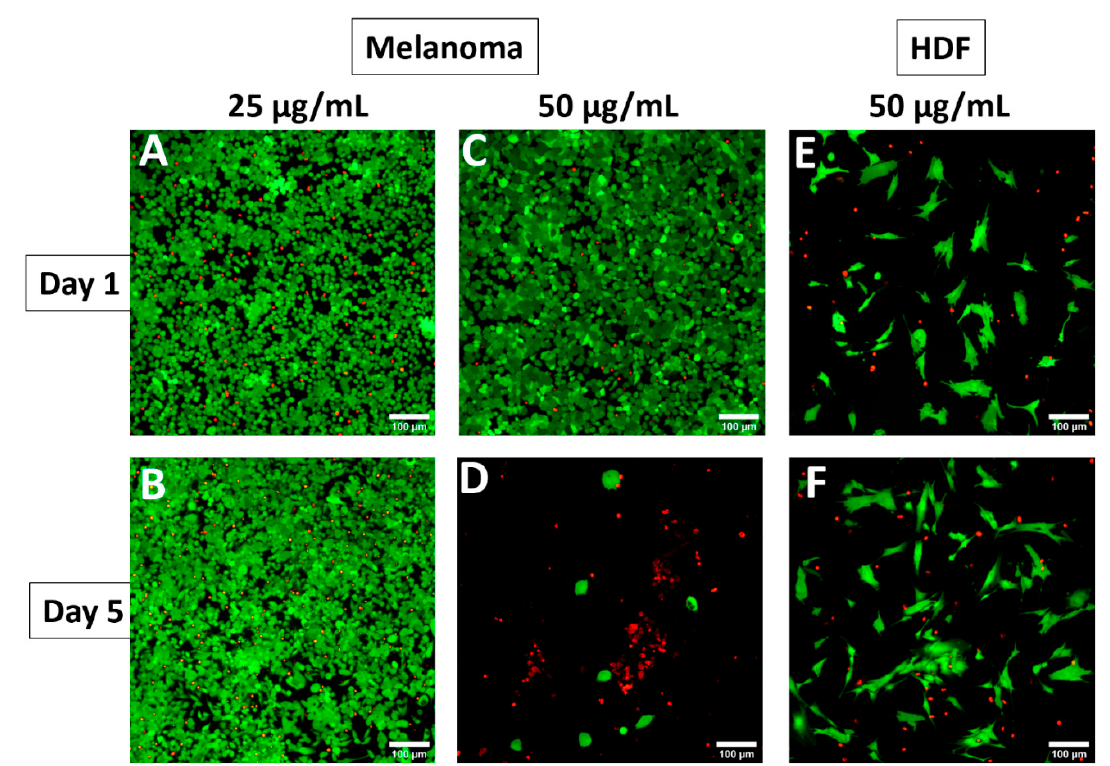
Figure 8. In vitro cytocompatibility study via live/dead assays. Representative live/dead images of melanoma cells in the presence of ( A , B ) AV-TeNPs at a concentration of 25 µg/mL at days 1 and 5 post-seeding onto well plate and ( C , D ) AV-TeNPs at a concentration of 50 µg/mL show significant anticancer properties of the NPs and ( E , F ) representative live/dead images of HDF cells in the presence of AV-TeNPs at a concentration of 50 µg/mL at days 1 and 5 post-seeding onto well plates.